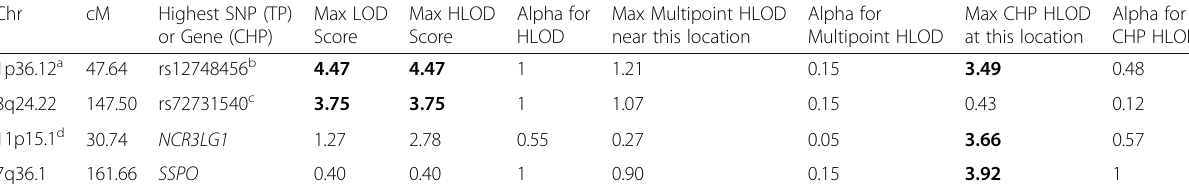
Table 2 HLOD Scores for Genome-wide Significant Chromosomal Regions Chr cM Highest SNP (TP)